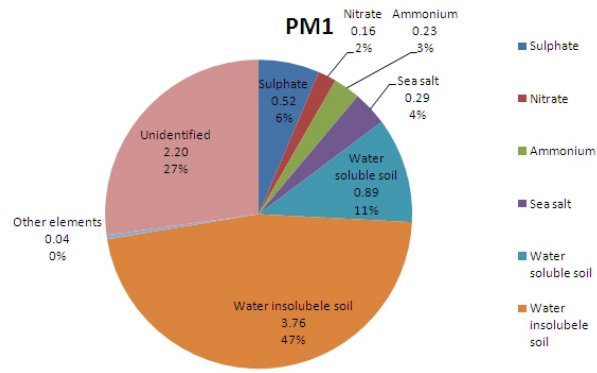
Fig. 6. Chemical composition of PM 1 measured at Hornsgatan.